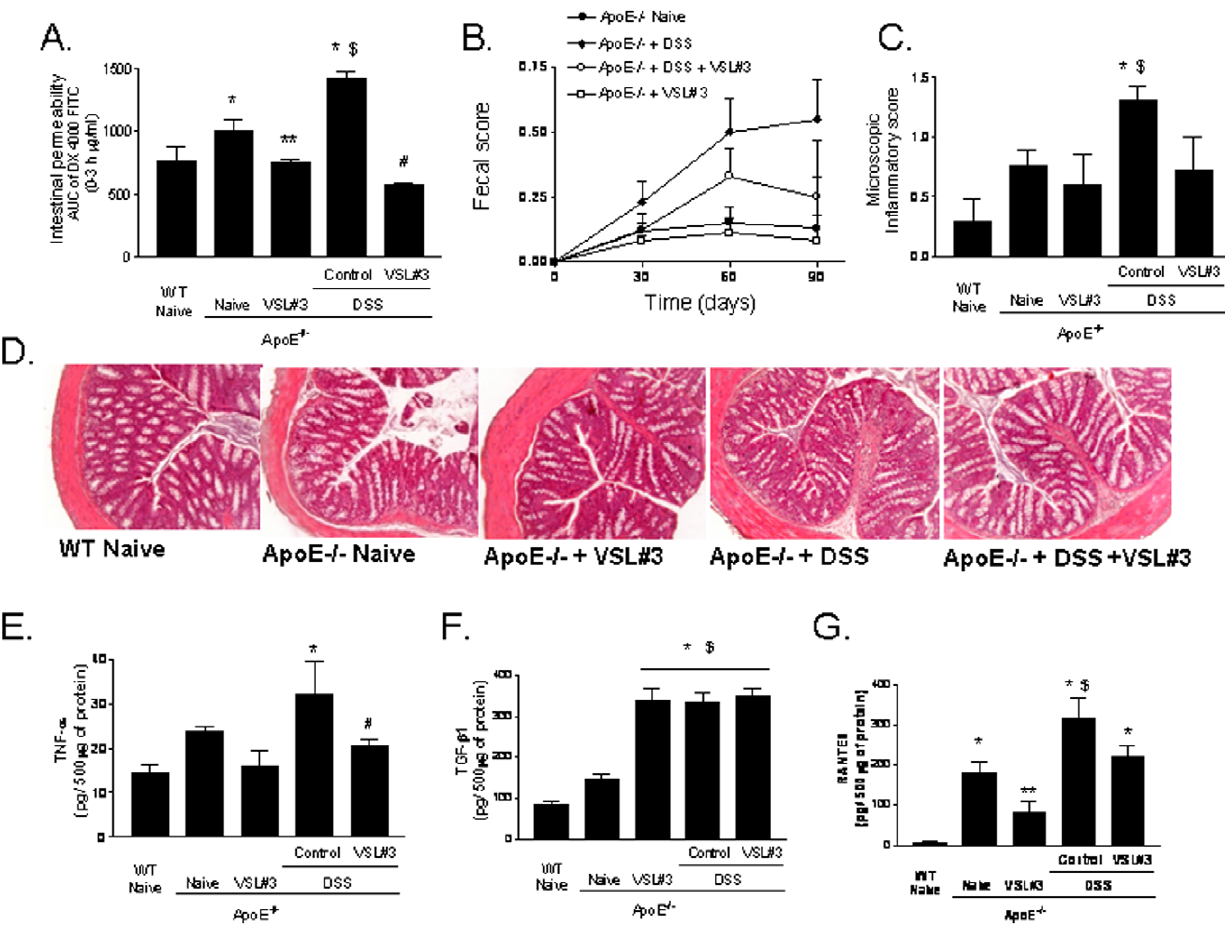
Figure 2. Effect of VSL # 3 administration in intestinal homeostasis. A ) Intestinal permeability assay after oral challenge with 4000 Da fluorescent dextran-FITC (DX-4000-FITC); area under curve (AUC) of plasma DX-4000–FITC ( m g/ml). B ) Fecal score. C ) Microscopy inflammatory score D ) Histolopathology analysis of colon samples obtained from experimental groups. Original magnification 20 6 , H&E staining. Colonic cytokines content: ( E ) TNF a , ( F ) TGF b 1 and ( G ) RANTES. Data are mean 6 SE of n=7 mice per group. * p , 0.05 ApoE 2 / 2 experimental group versus naive wild type group; ** p , 0.05 ApoE 2 / 2 naı¨ve group versus ApoE 2 / 2 plus VSL # 3 group; $ p , 0.05 ApoE 2 / 2 naive group versus ApoE 2 / 2 plus DSS group; # p , 0.05 ApoE 2 / 2 plus DSS group versus ApoE 2 / 2 plus DSS and VSL # 3